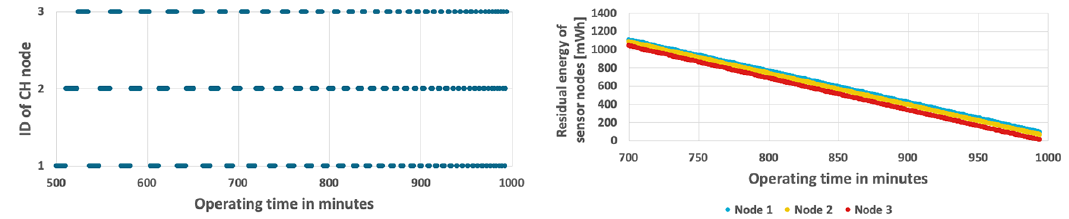
Figure 9. Energy consumption by sensor nodes for EDCR algorithm and fixed probability of event